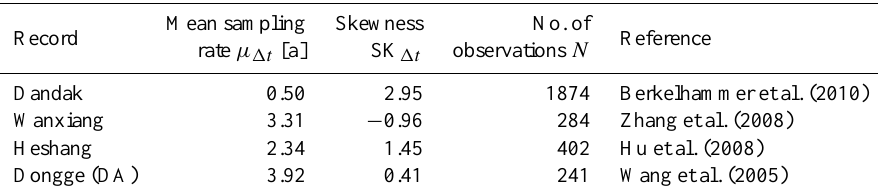
Table 2. Mean sampling intervals,variances and skewnesses of the inter-sampling time distributions and number of observations in the overlapping section of the used paleo proxy records